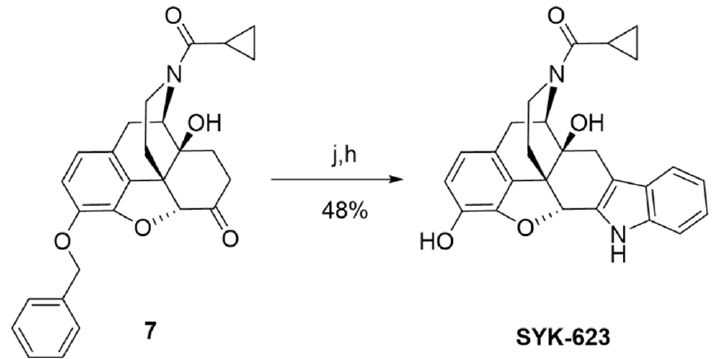
Scheme 3. Reagents and conditions: (j) phenyl hydrazine, AcOH, reflux; (h) 10% Pd/C, H 2 , MeOH.